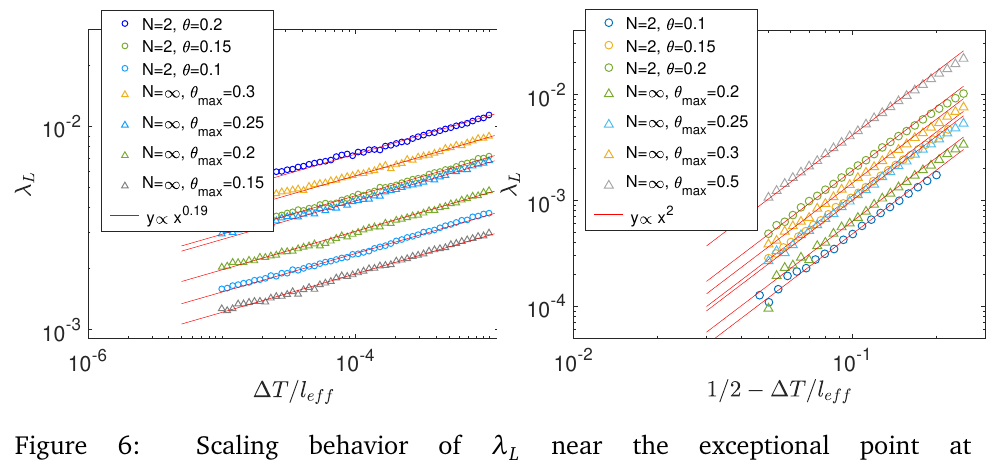
Figure 6: Scaling behavior of λ near the exceptional point at L ∆ T / l − 1 / 2 = 0 (left) and the trivial point at ∆ T / l = 1 / 2 : = T θ / l θ eff ,eff eff (right) in Fig. 5. The fitting lines (in red) are y ∝ x 0.19 on the left and y ∝ x 2 on the right, respectively. We study both the driving protocols with N = 2 and N = ∞ random